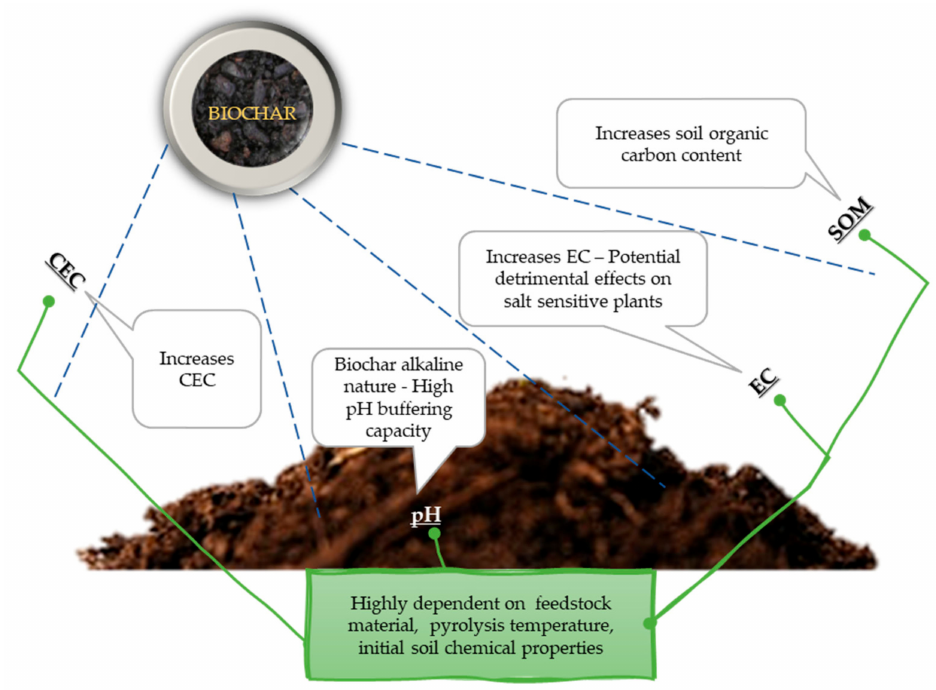
Figure 3. Potential effects of biochar application on basic soil chemical properties. CEC: cation exchange capacity; EC: electrical conductivity; SOM: soil organic